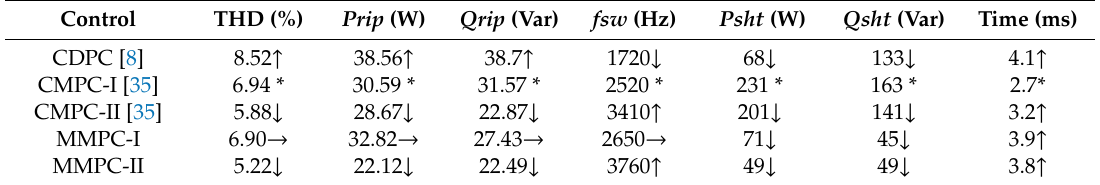
Table 4. Quantitative Comparison of Steady-State and Dynamic-State Performance in Experiment.